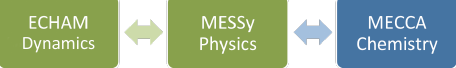
Figure 1. Phases of EMAC. Green phases run on the Cluster; blue phases run on the